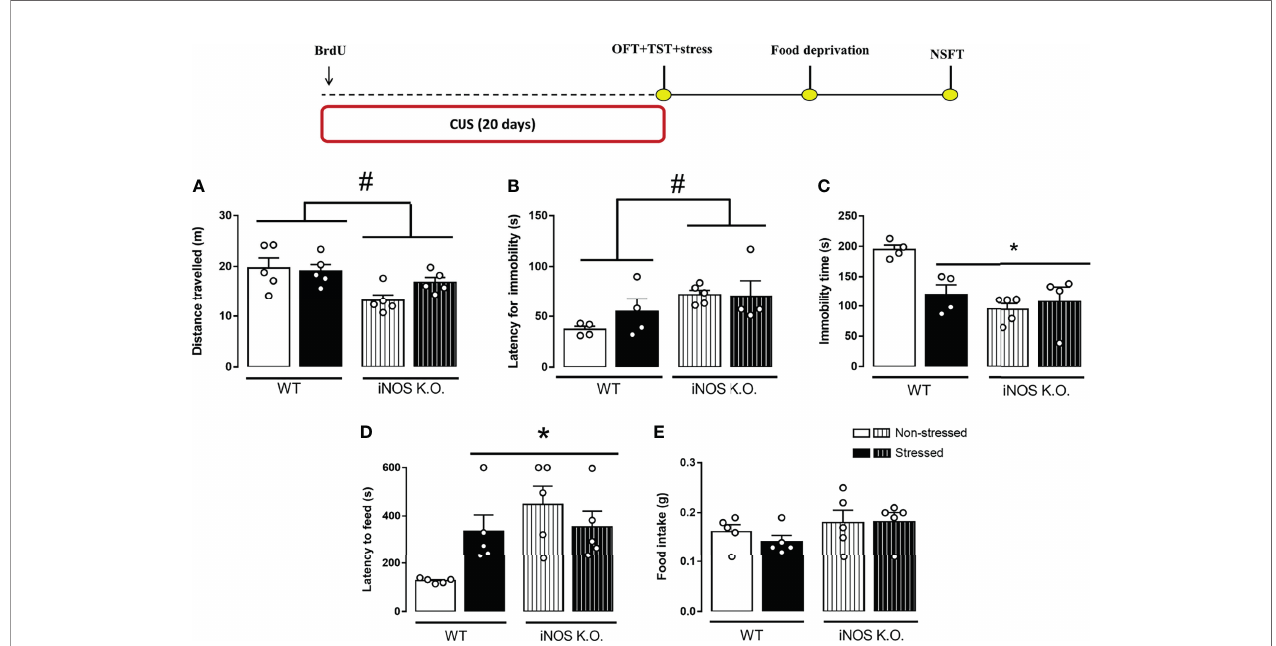
FIGURE 4 | Distinct behavioral response to CUS of outbred WT and iNOS K.O. mice. (A) total distance traveled on the open fi eld test (n=5/group); latency for the fi rst immobility episode (B) and total immobility time on the tail suspension test (n=4,4,5 and 4, respectively) (C) ; (D) latency to feed in a novel environment (E) : total feeding consumption during fi ve minutes in home-cage (n=5/group). Data presented as mean ± S.E.M. *p < 0,05 from WT non-stressed; # indicates p < 0.05 on genotype